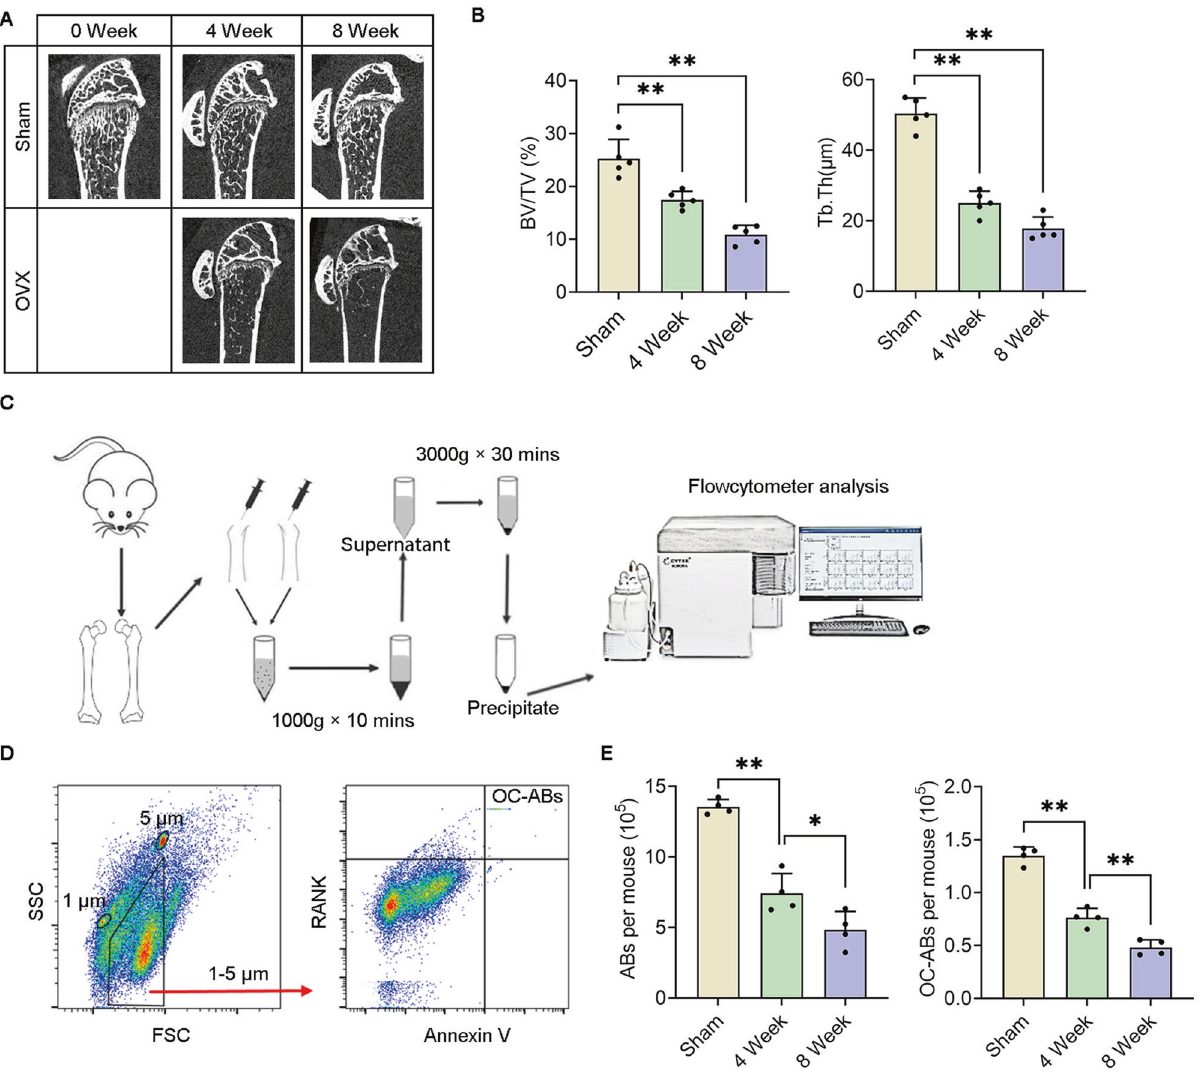
Fig. 1 The number of osteoclast-derived apoptotic bodies gradually decreases in the process of osteoporosis. A Representative micro-CT images of osteoporotic mice at various stages. B Quanti fi cation of bone volume fraction and mean thickness of trabecular bone, n = 5. C Schematic representation of the apoptotic bodies extraction from femoral bone marrow. D PE-RANK and FITC-Annexin V label 1 – 5 μ m osteoclast-derived apoptotic bodies. E Quanti fi cation of total apoptotic bodies and osteoclast-derived apoptotic bodies from femoral bone marrow in each time period, n = 4. The data in each panel represent the means ± SD. p values were obtained by student ’ s two-tailed unpaired t test, * p < 0.05, ** p < 0.01, ns non-signi fi and bisphosphonates during osteoporosis treatment, and also provide a reference for the prevention, diagnosis, and treatment of osteoporosis.